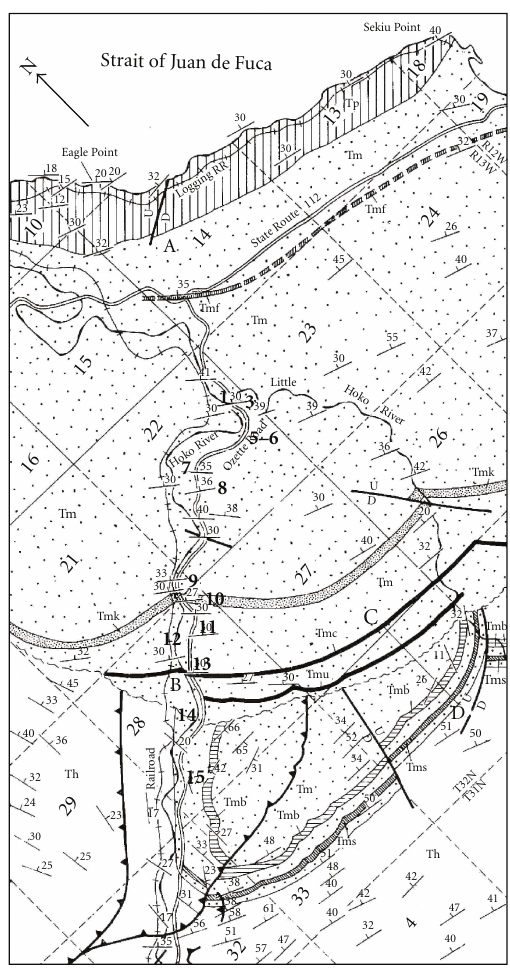
Figure 2: Index map showing location of sampling sites (bold numbers) along Ozette Road and the Hoko River. Formation abbreviations as in Figure 1(a). Modified from Snavely et al. [8, Figure